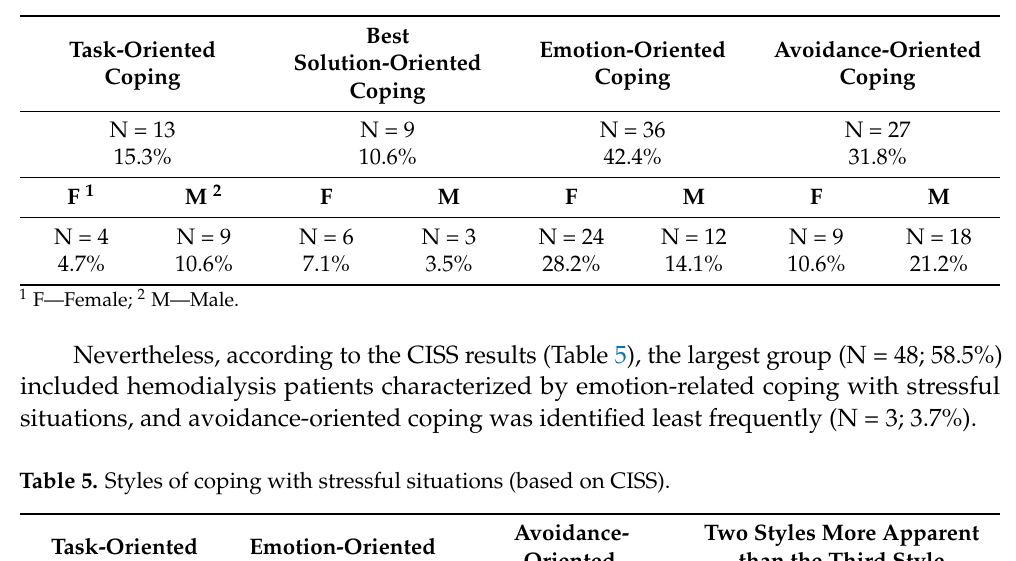
Table 4. Styles of coping with the disease (based on the Brief Method of Evaluating Coping with Disease).